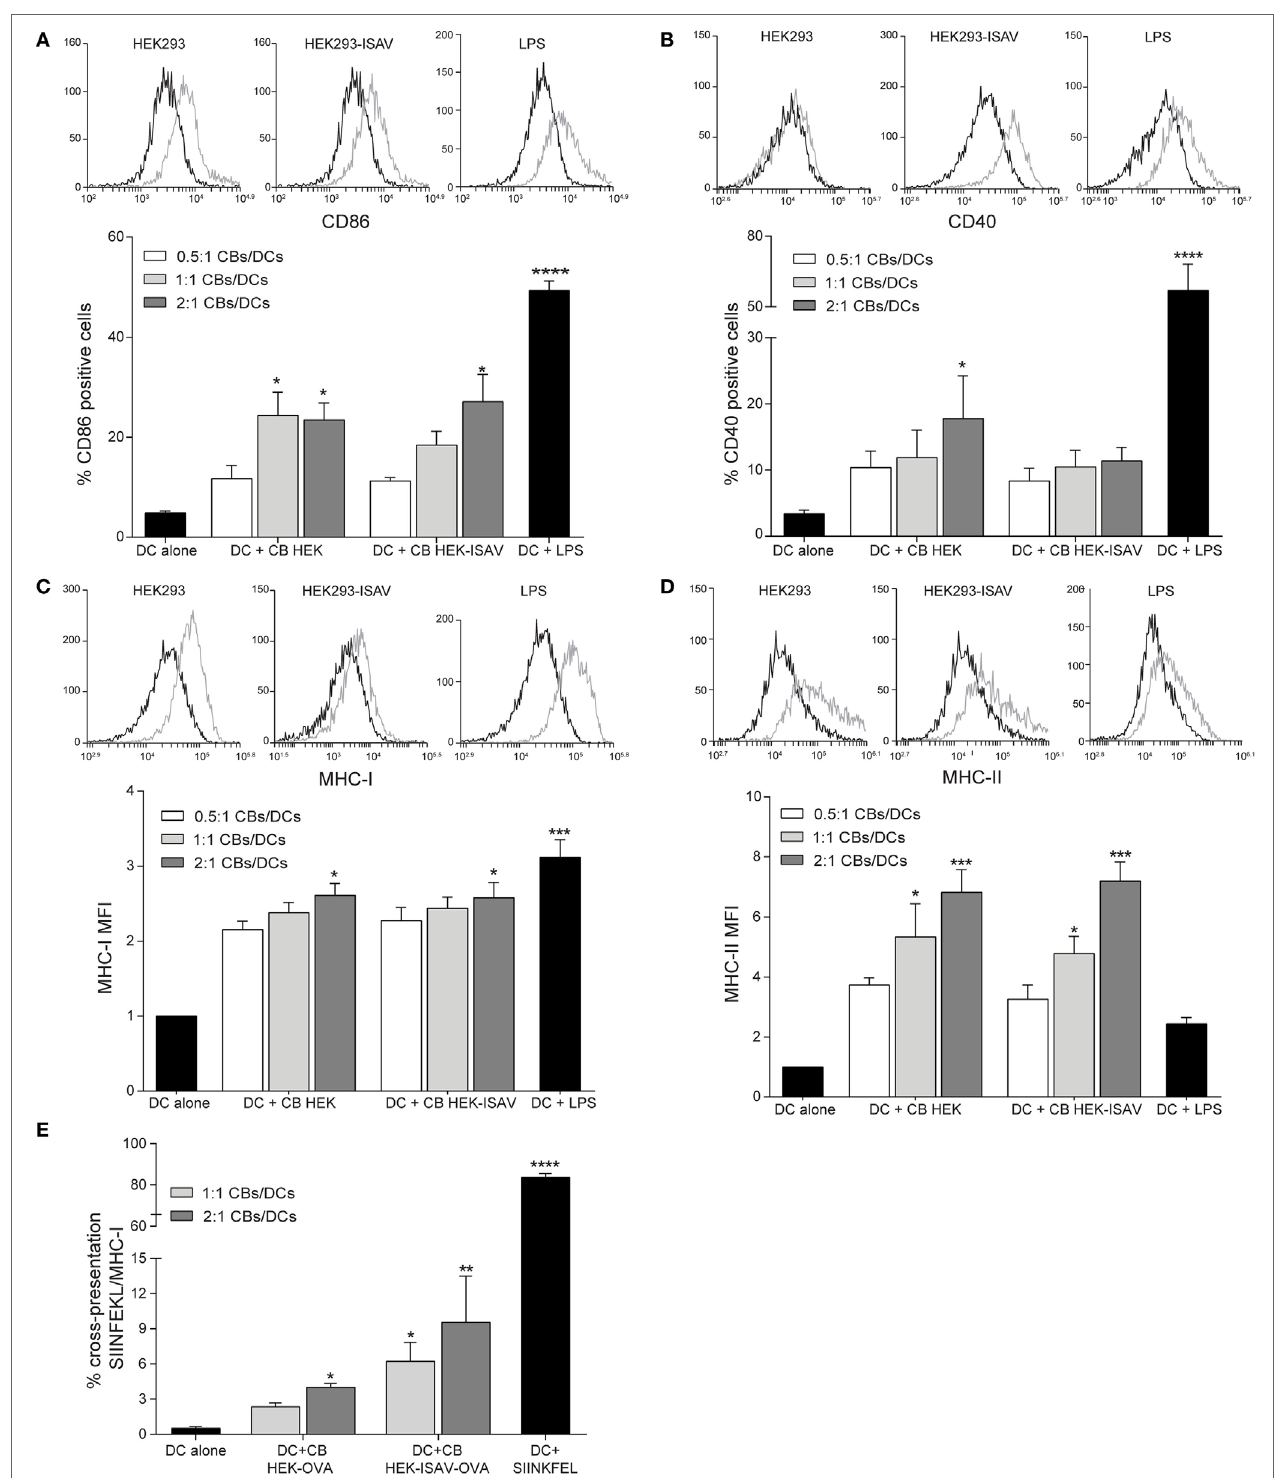
FigUre 3 | HEK293 cell bodies (CBs) induce dendritic cell maturation. Dendritic cells were challenged with different ratios of CBs derived from non-transfected and infectious salmon anemia virus (ISAV)-transfected HEK-293 cells for 24 h. Maturation markers were measured by flow cytometry, for each marker, a representative histogram of the ratio 1:1 [CBs/DCs] is shown (control, black line; stimulated, gray line). (a) % CD86 and (B) % CD40 positive cells. (c) MHC-I and (D) MHC-II mean fluorescence intensity (MFI) ( n = 5). (e) Cross-presentation was measured by the detection of SIINFEKL-MHC-I ( n = 6). Statistical analyses were performed using Kruskal–Wallis ANOVA (* p < 0.05, ** p < 0.005, *** p <